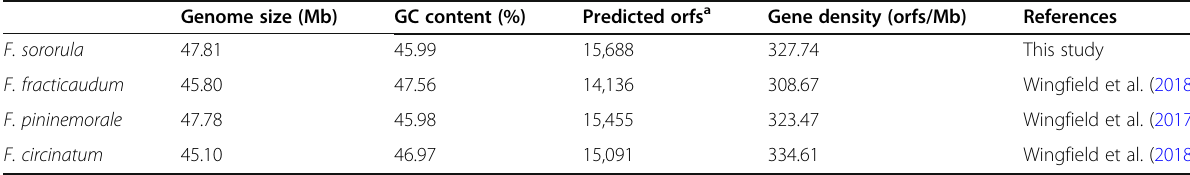
Table 2 Genome statistics for Fusarium sororula and its close relatives